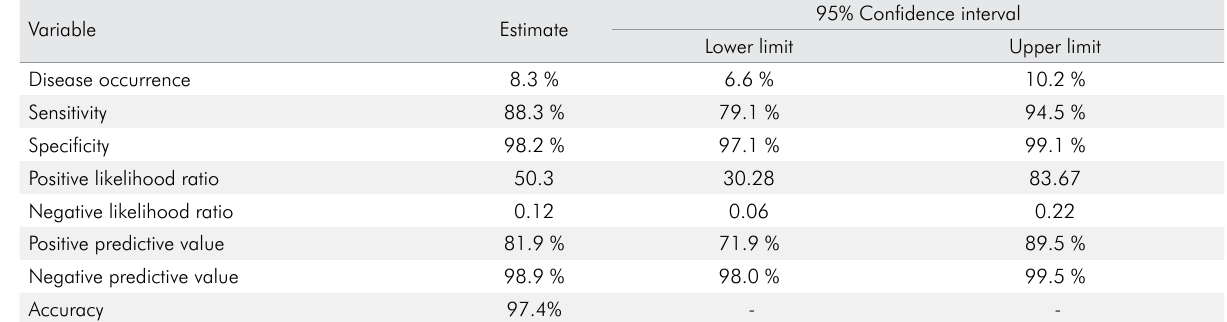
Table 5. Accuracy, predictive value, sensitivity and specificity of clinical examination for PMD and malignant lesions in the lips.